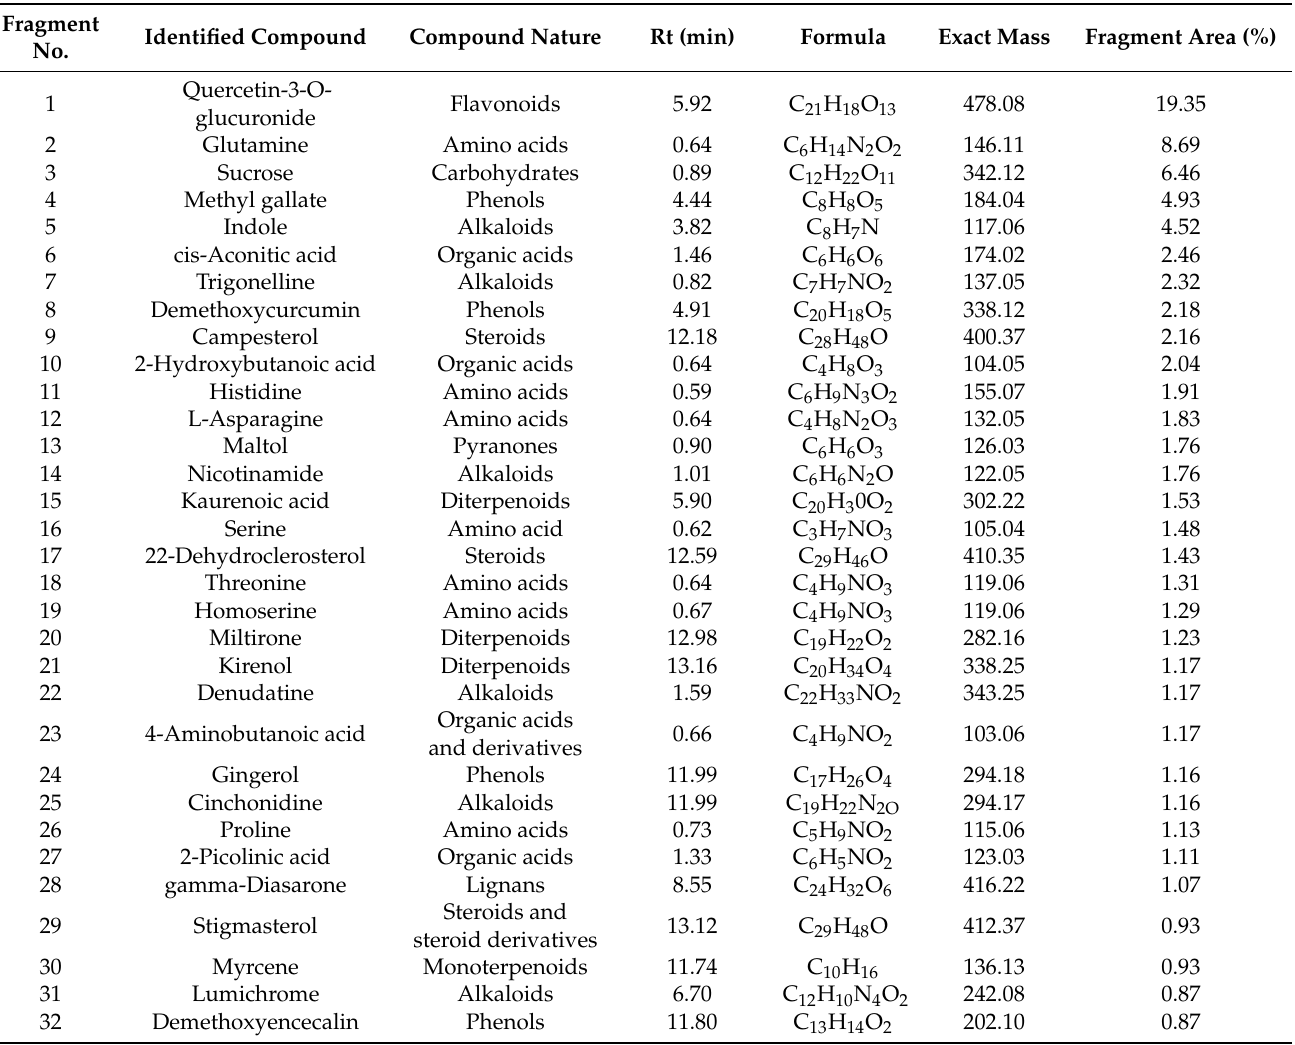
Table 3. The major compounds identified in Fragment 1 from C. communis Linn by the UHPLC– MS